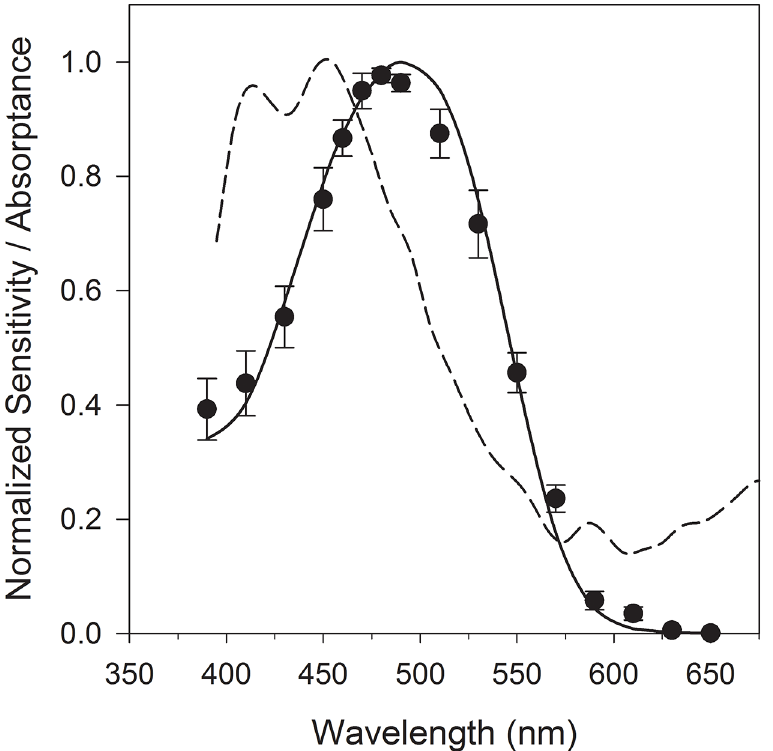
Fig 2. Thysanoessa inermis visual spectral sensitivity and spectral composition of skylight in the polar night (dashed line). Spectral sensitivity data are means ( ± standard error, n = 5) with the best-fit rhodopsin absorptance (solid line, λ max = 492 nm). Spectral irradiance measured in air at noon on the 21 st of January 2015 has been normalized to its peak; integrated absolute irradiance as PAR for this measurement was 1.3x10 -5 μ mol photons m -2 s -1